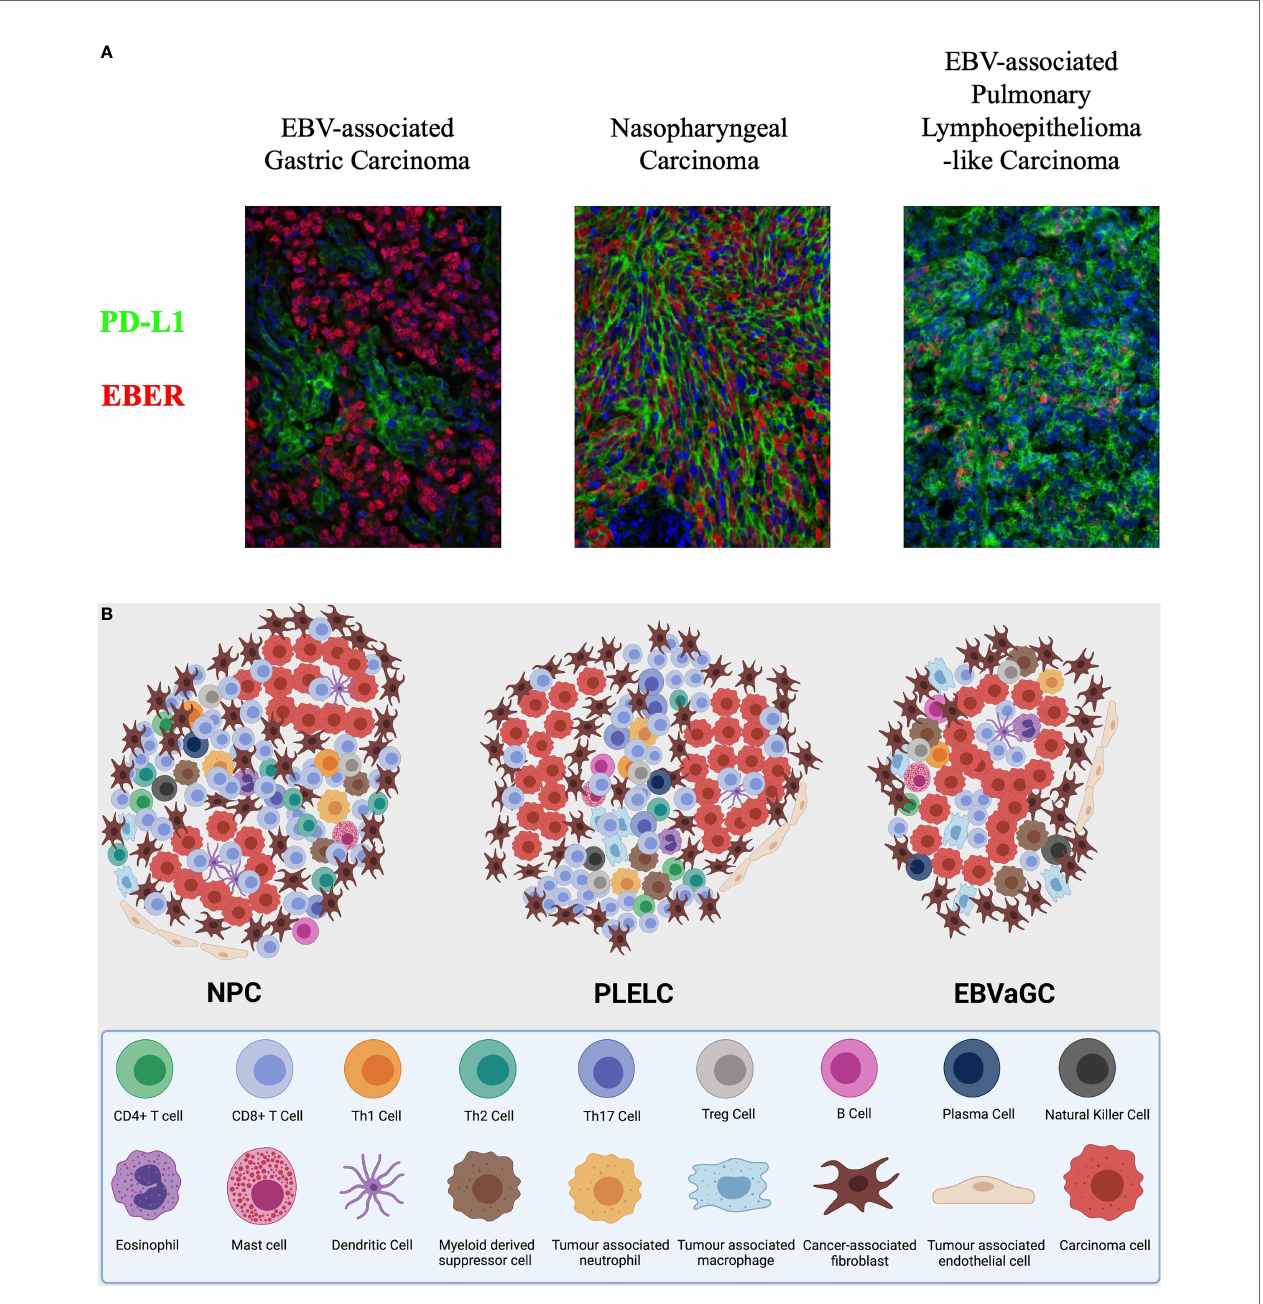
FIGURE 2 | (A) Integrated multispectral imaging technique that simultaneously detects EBER and immune cell protein marker (PDL1) in formalin- fi xed, paraf fi n- embedded (FFPE) tissues of EBV-associated epithelial cancers — nasopharyngeal carcinoma (NPC), pulmonary lympho-epithelioma-like carcinoma (PLELC), and EBV- associated gastric cancer (EBVaGC). (B) A symbolic illustration of the tumour immune microenvironment of nasopharyngeal carcinoma (NPC), lymphoepithelioma-like carcinoma (LELC), and EBV-associated gastric carcinoma (EBVaGC). NPC and LELC are similar with an abundance of immune cells including predominantly T cells. The cell types present include CD4+ T cells, CD8+ T cells, T regulatory cells, B cells, NK cells, myeloid cells, and fi broblasts in the stroma and some immune cells in fi ltrating the tumour nests. There are more CD8 than CD4 T cells but the illustration does not represent relative abundance. The fi broblasts are thought to be higher around the edge of the tumour nests. Immunosuppressive cells including Tregs, tumour associated macrophages, and tumour associated neutrophils are present. Inspired by Tan GW, Visser L, Tan LP, van den Berg A, Diepstra A. The Microenvironment in Epstein-Barr Virus-Associated Malignancies. Pathogens . 2018;7(2):40.